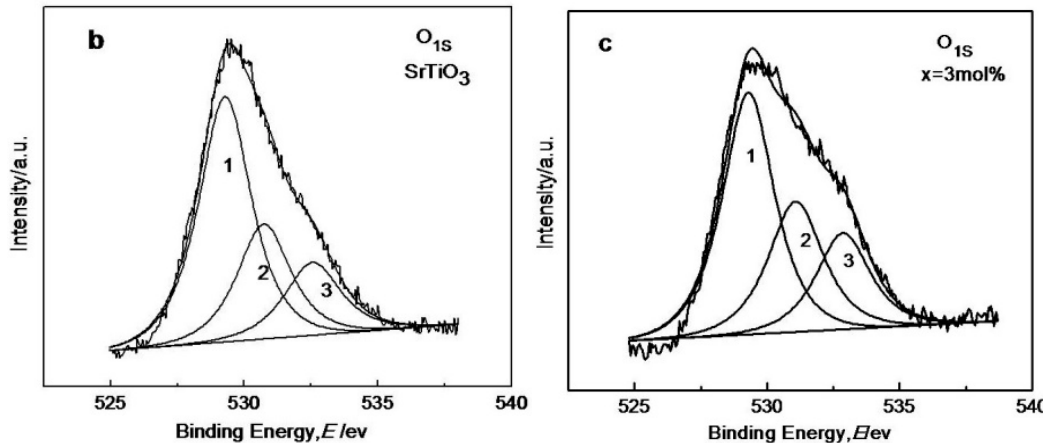
Figure 8. XPS scans for pure and 3 mol % Ce 4+ doped SrTiO 3 ( a ) Full scan; ( b ) O 1s peaks on pure SrTiO 3 ; ( c ) O 1s peaks on 3 mol % Ce 4+ doped SrTiO 3 .